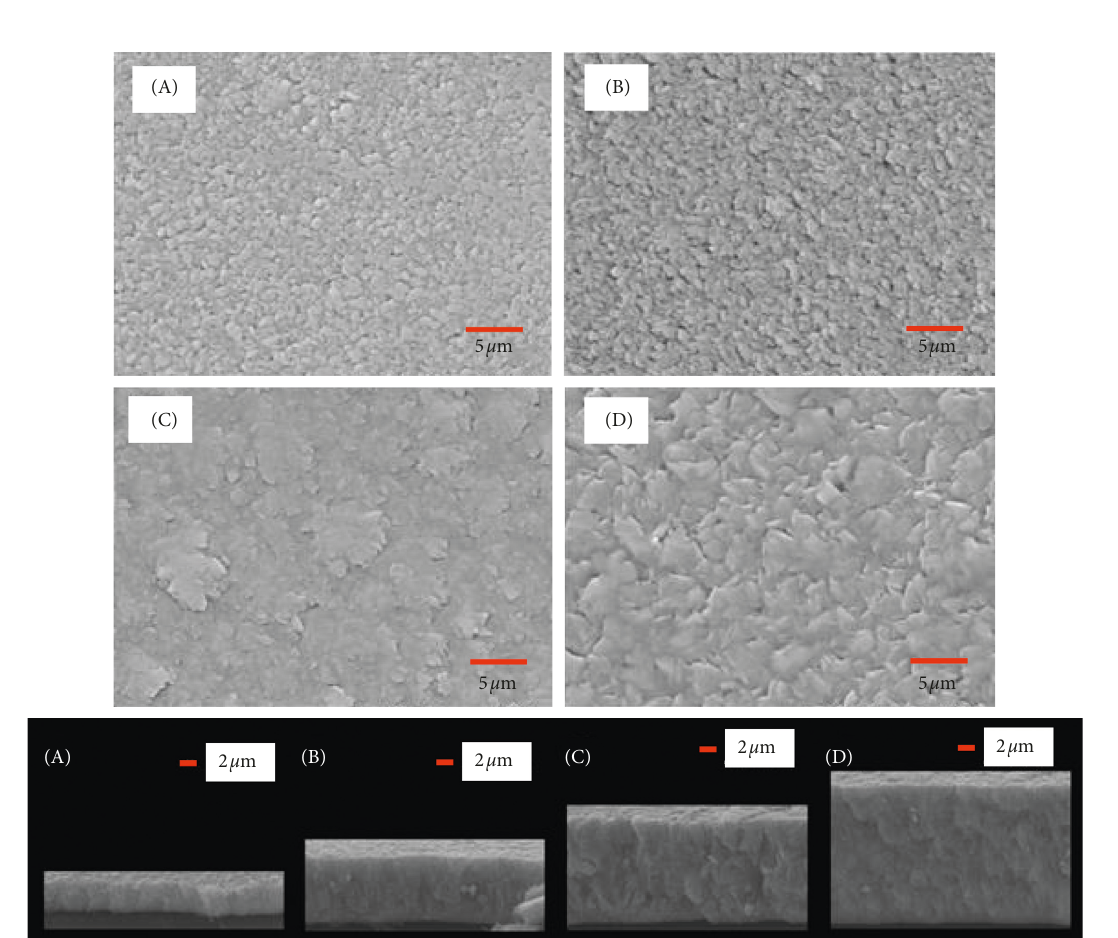
Figure 2: Surface morphological and cross-sectional images of Sb (C) 45, and (D) 60 min.